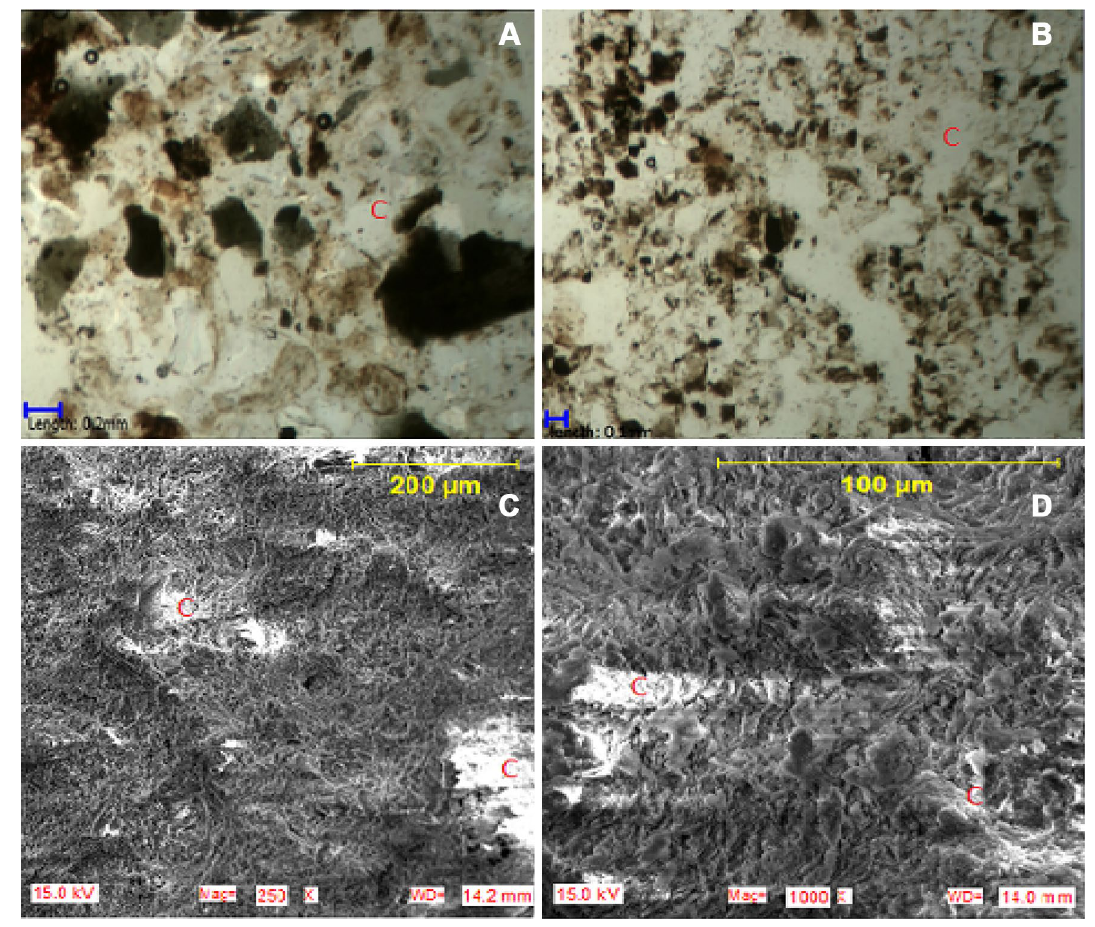
Fig. 18 Development of calcite in the analysed sample. C